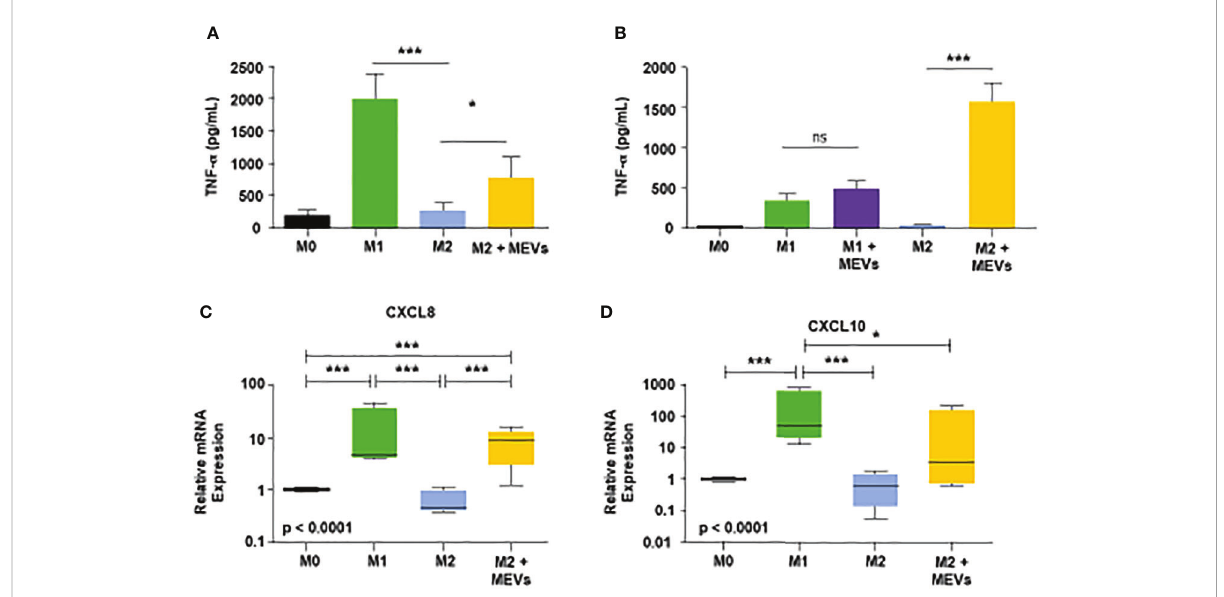
FIGURE 4 (A) Human M1 vesicles repolarize M2 macrophages. Human PBMC-derived monocytes were cultured with M-CSF (50ng/mL) for six days. Cells were stimulated, and supernatants were assayed for human TNF- a after 24 hours. From left to right on the graph: M0 macrophages (black),